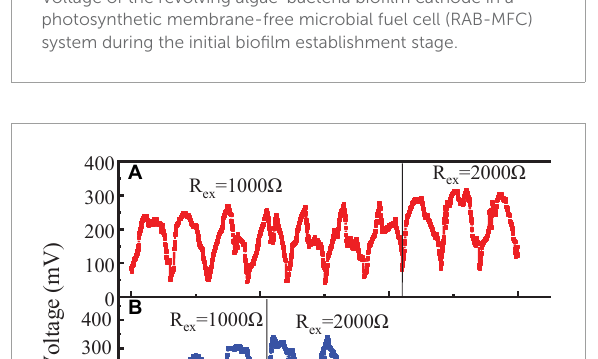
FIGURE2 Voltage of the revolving algae-bacteria biofilm cathode in a photosynthetic membrane-free microbial fuel cell (RAB-MFC) system during the initial biofilm establishment stage.